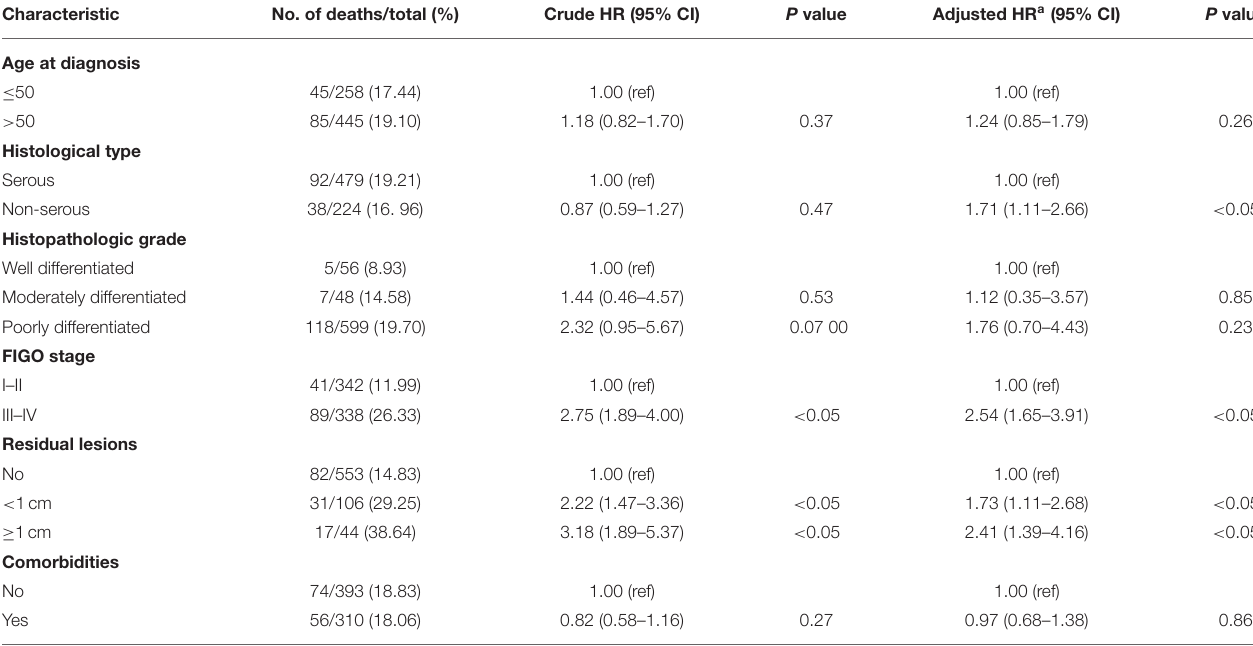
TABLE 2 | Selected clinical characteristics and associations with all-cause mortality among women diagnosed with ovarian cancer ( N = 703).